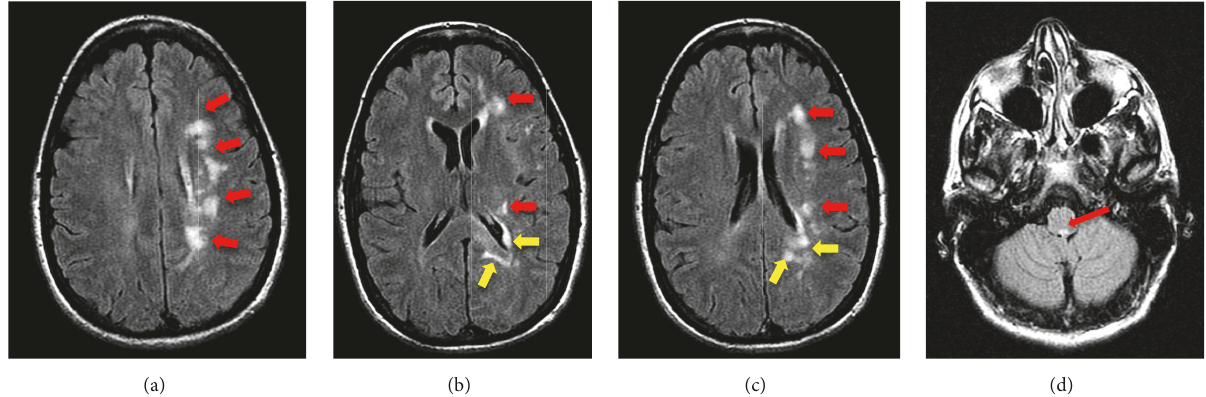
Figure 1: Axial brain MRI (a-d) depicts left-sided (a-c) cerebral white matter lesions (red arrows), periventricular lesions (b and c) of the left frontal and posterior horns of the lateral ventricles (yellow arrows), and T2-hyperintense foci of the midbrain (d) corresponding to the medial longitudinal fasciculus (red arrow).